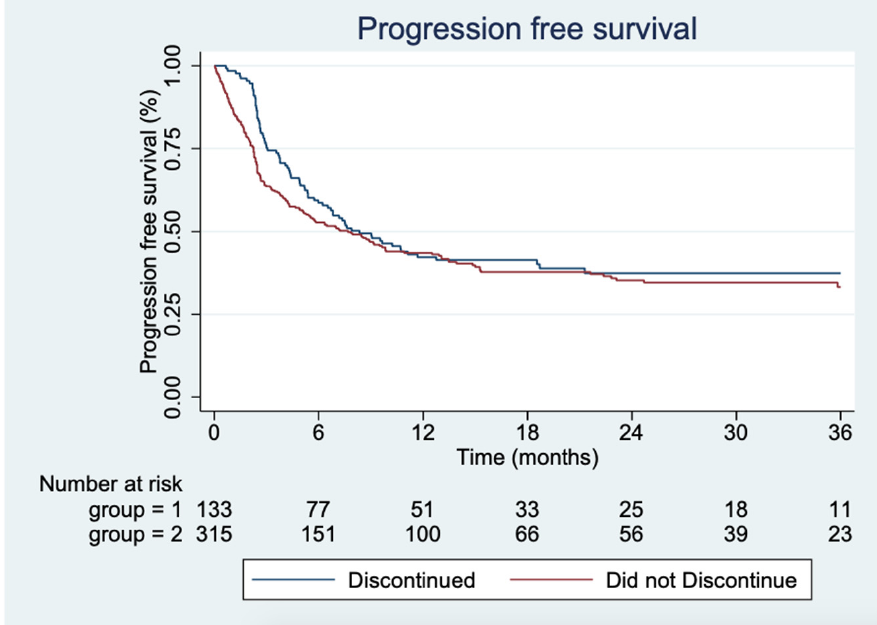
Figure 2. Kaplan–Meier plot showing the progression-free survival for the two groups, respectively. Table 3. Univariate and multivariate Cox regression analyses of potential confounding factors for PFS. Variation Univariate Analyses Multivariate Analyses